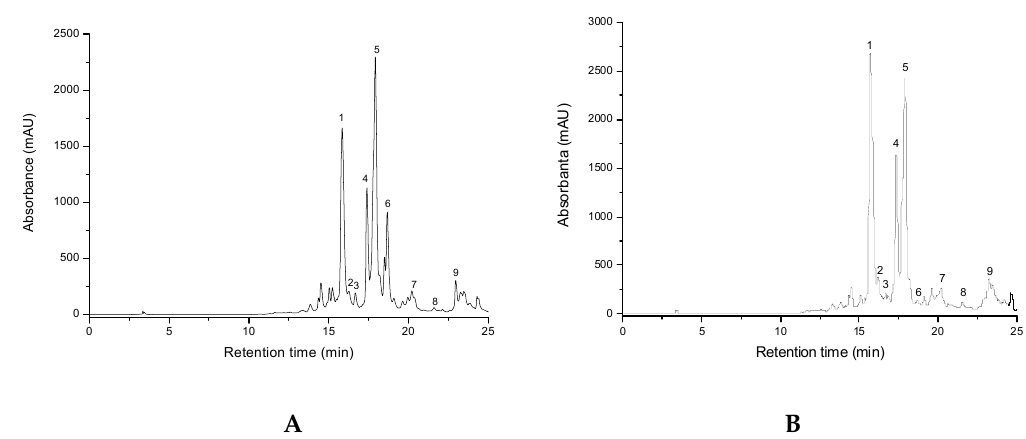
Figure 1. HPLC chromatograms for T. marschallianus from culture (TMc) ( A ) and T. marschallianus (TMs) ( B ). Notes : Chromatographic conditions were as given in the Experimental section. The identified compounds: 1. luteolin-7- O -glucuronide, 2. quercetin-3- O -glucoside, 3. quercetin-7- O -arabinoside, 4. apigenin-7- O -glucuronide, 5. methyl-rosmarinate, 6. rosmarinic acid, 7. quercetin, 8. luteolin, 9. apigenin.